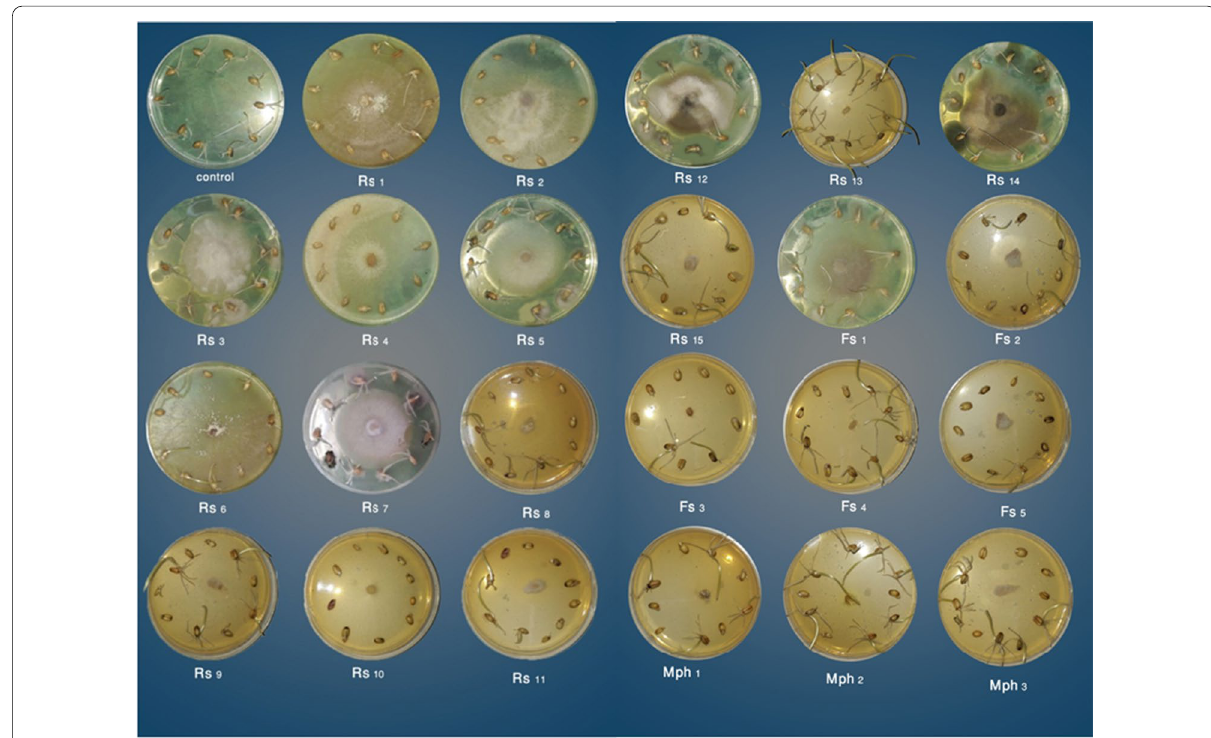
Fig. 10 Effect of R. solani , F. solani and M. phaseolina on germination of wheat seeds on water agar